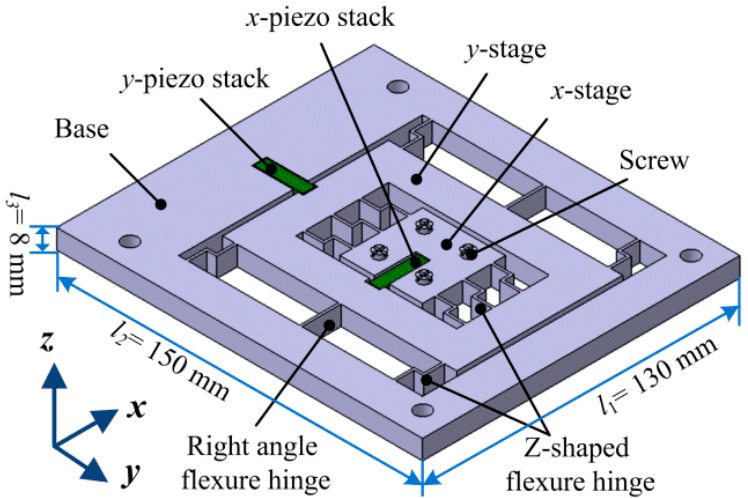
Figure 5. Structure of the proposed 2-DOF (two degrees of freedom) piezoelectric-driven platform.